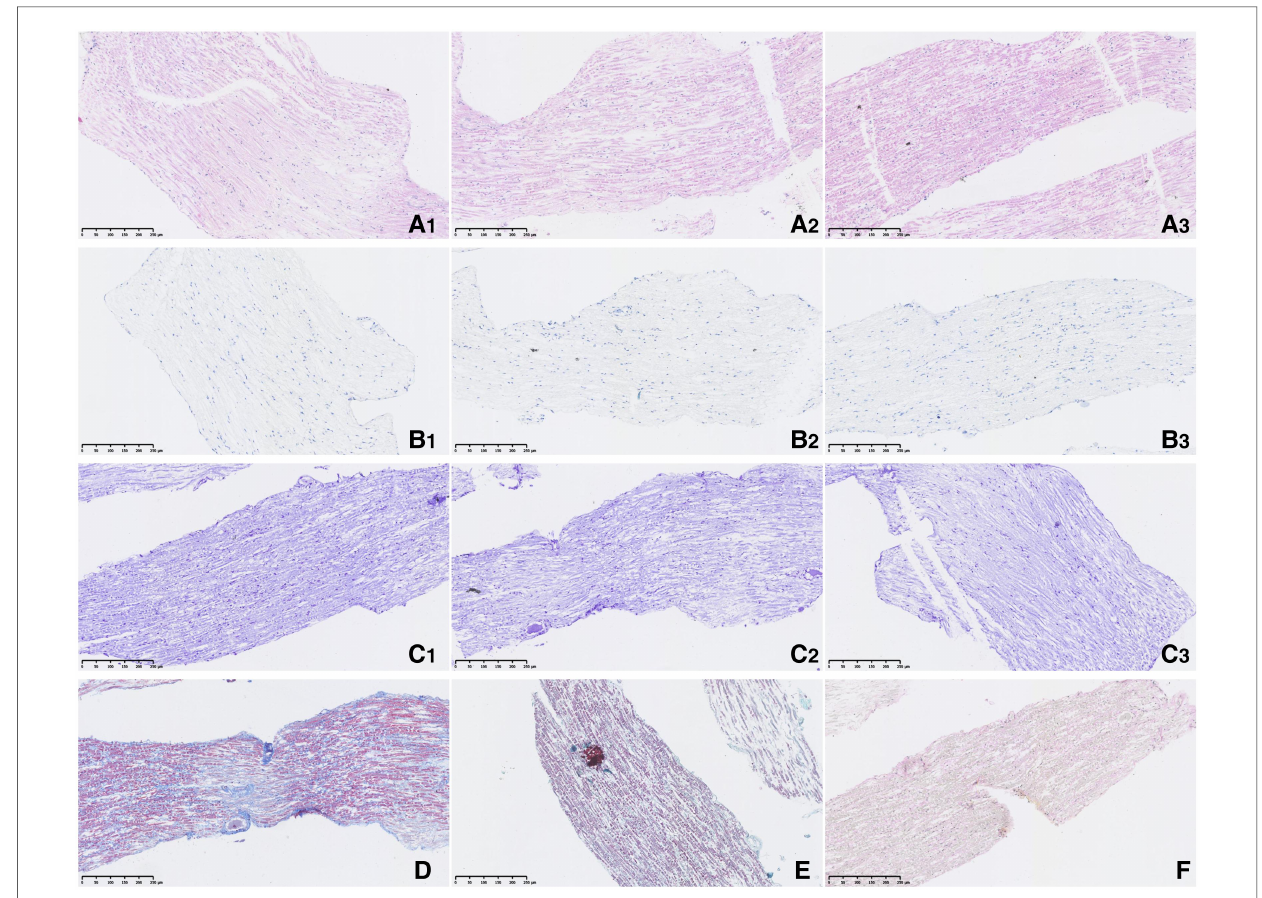
FIGURE 4 Pathological morphology of nerve tissue. ( A ). Hematoxylin Eosin (A1, A2, A3×200); ( B ). Toluidine Blue (B1, B2, B3×200); ( C ). Methyl Violet (C1, C2, C3× 200); ( D ). Massion (×200); ( E ). MGT (×200); ( F ). Van Gieson